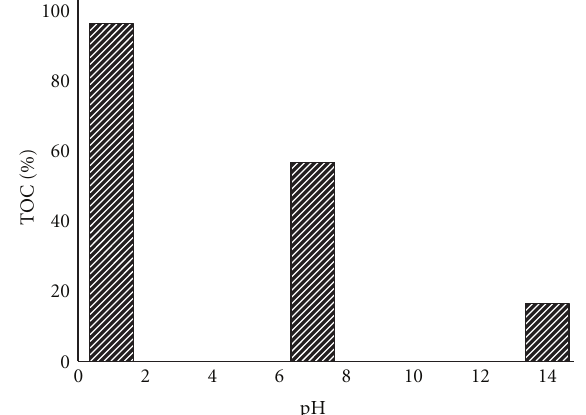
Figure 3: TOC values before and after the electrochemical oxi- dation process using BDD, at di ff erent pH values (1, 7, and 14), applying 2 A ( j = 0 . 32 Acm − 2 ) of current over 2 hours in pretreated industrial